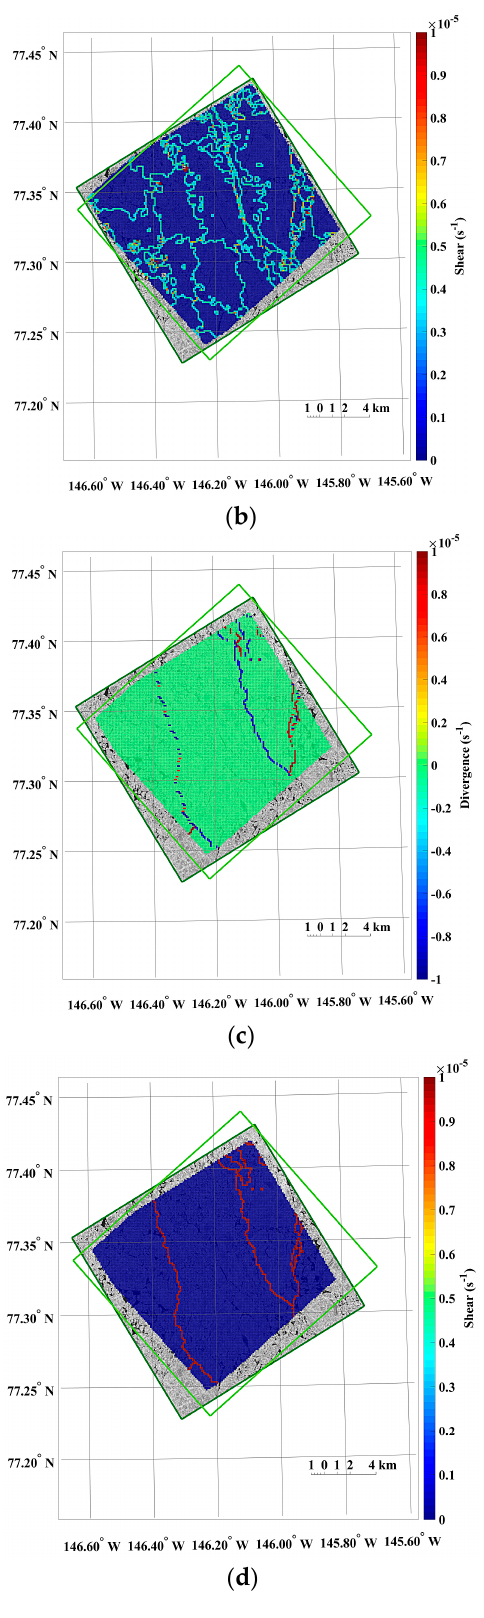
Figure 13. An example of the sea ice deformation using the KOMPSAT-2 image acquired on 14 August 2014 (i.e., prior image) and the KOMPSAT-3 image acquired on 14 August 2014 (i.e., posterior image: ( a ) divergence and ( b ) shear from the image pair resampled to the spatial resolutions of 4 m; and ( c ) divergence and ( d ) shear from the image pair resampled to the spatial resolutions of 15 m.